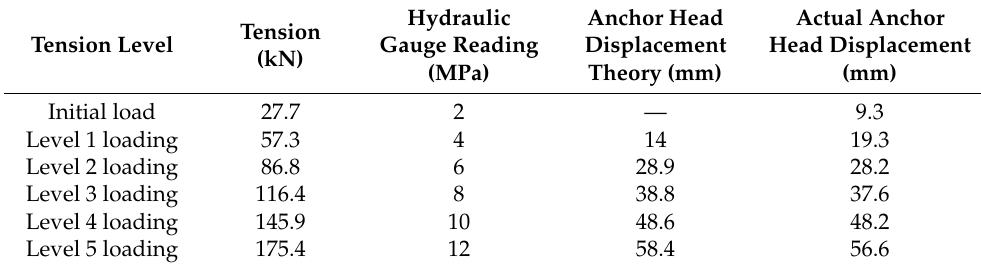
Table 2. Summary of actual tension